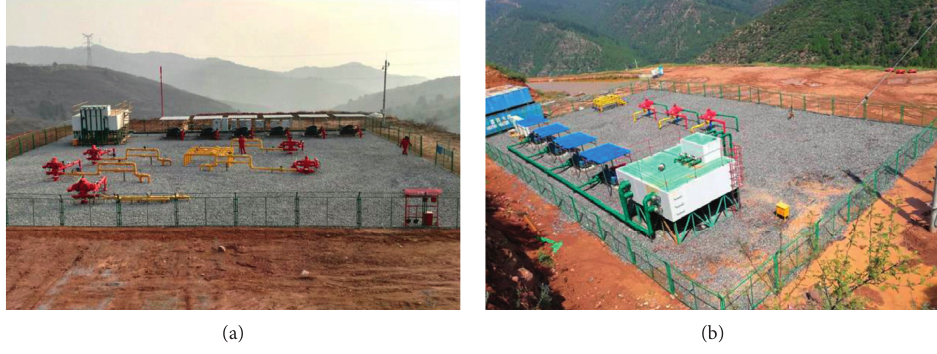
Figure 2: Surface layout of CBM well site.